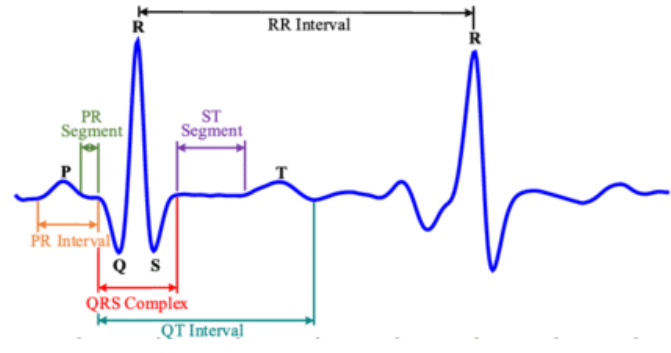
Figure 3. R peaks in ECG signal